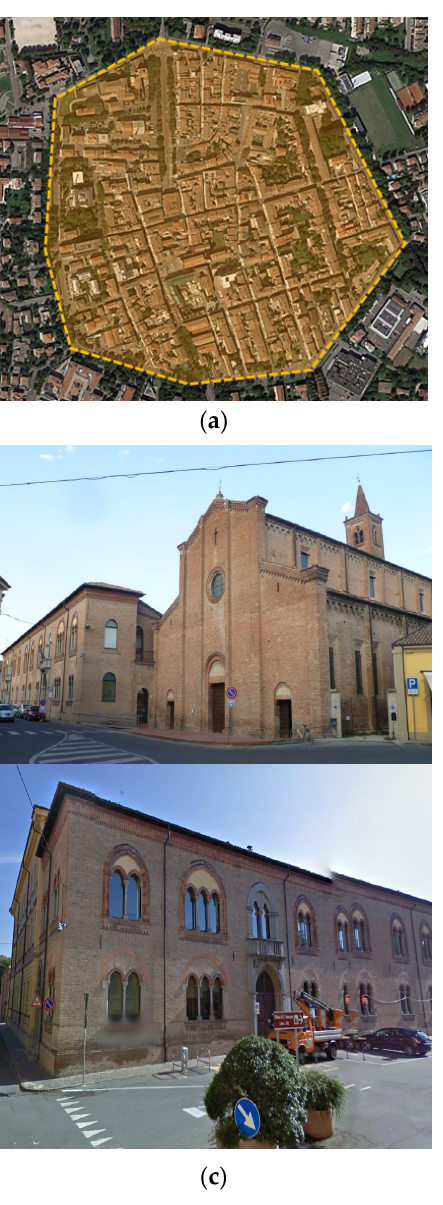
Figure 2. Octagonal compartment and urban blocks plan of the city ( a , b ) [30]; ( c , d ) some building typologies in the city centre.